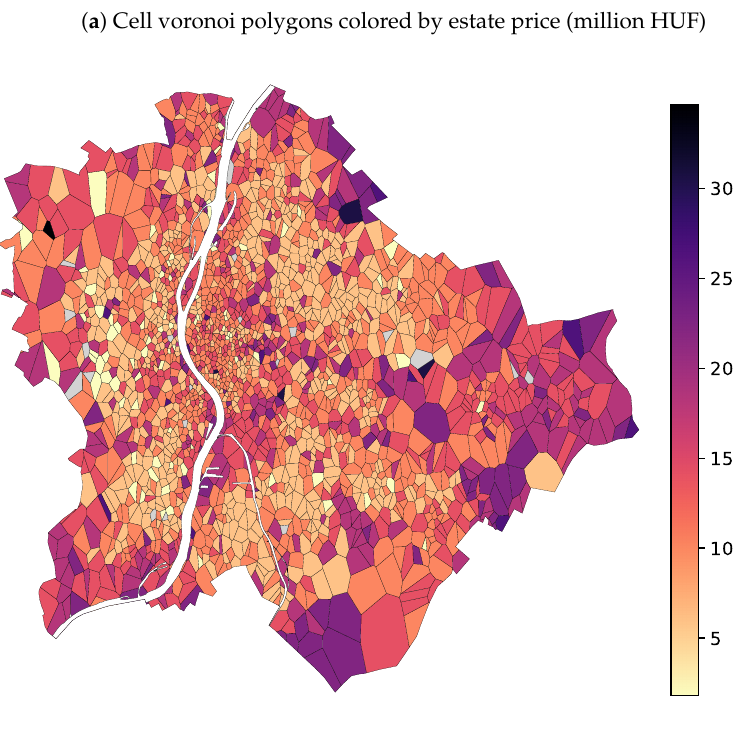
Figure 8. Voronoi polygons of the merged mobile phone cells colored by the estate prices and the Radius of Gyration. River Danube is represented with white, and the cells without enough data colored with light